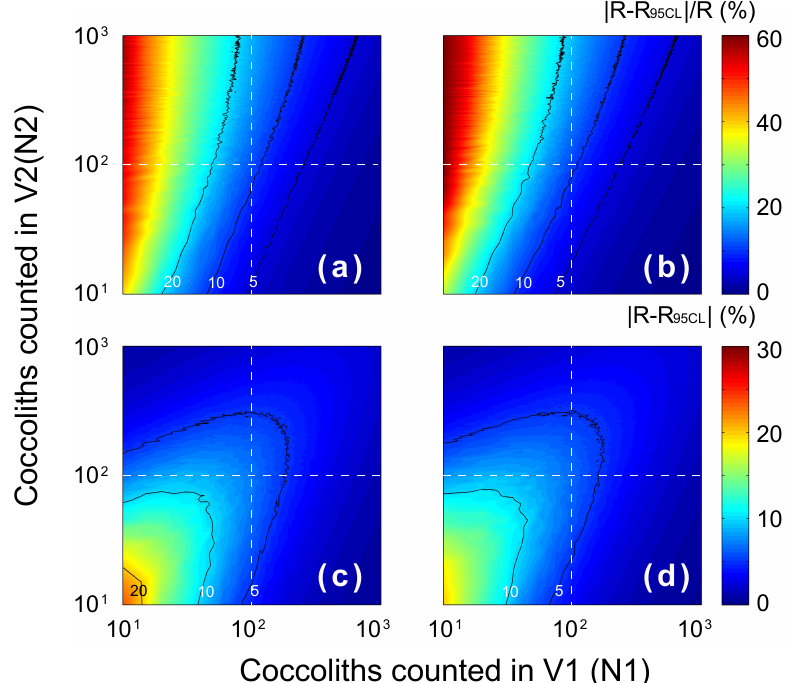
Figure E1. The error distribution with different N 1 and N 2 (ranging from 1 to 1000) simulated 5000 times by Matlab with assumptions that the error distributions of N 1 and N 2 follow the Poisson distribution. The calculation of R follows Eq. (2)–(5), and here we assume that the numbers of FOV are equal ( n 1 = n 2 ). Counter lines mark values equal to 5, 10 and 20. Panels (a) and (c) represent the lower 95% confidence level, and (b) and (d) represent upper 95% confidence level. Panels (a) and (b) show the relative error of R , and (c) and (d) represent the absolute error of R